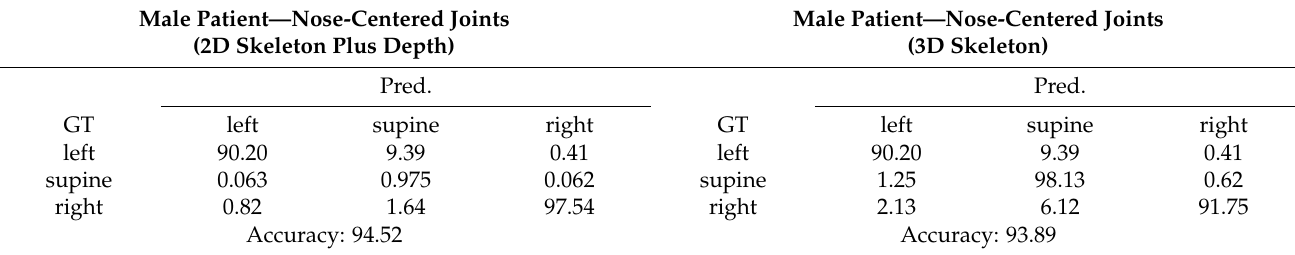
Table 8. Accuracy and confusion matrix (all numbers in terms of %) for Setting